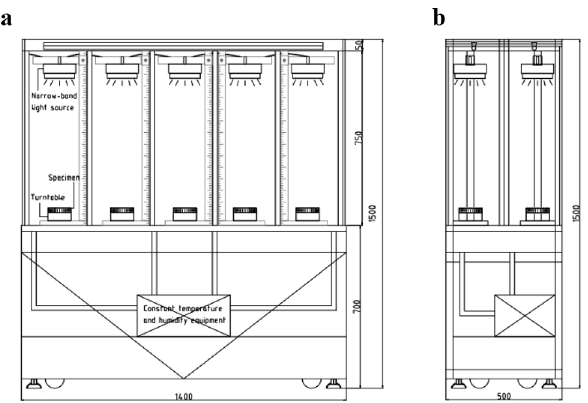
Figure 3. Experimental device diagram. ( a ) The front elevation, ( b ) The side elevation.